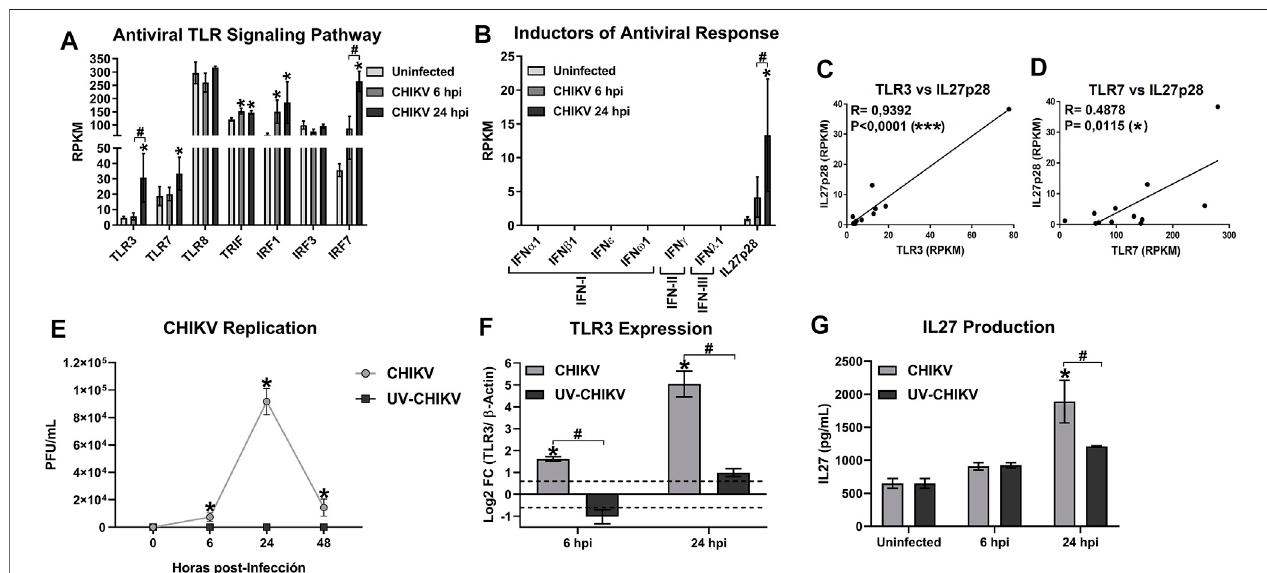
FIGURE 5 | The CHIKV infection of MDMs induces the mRNA expression of TLR3 signaling components, IRF1, and IL27p28. Human MDMs cultures were left uninfectedorinfectedwithCHIKVatMOI5.Celllysateswereobtainedat6and24 hpi,andRNA-seqandRT-qPCRwereperformed.mRNAsabundance(RPKM)ofTLR signaling pathway components and IRFs (A) , IFNs and IL27p28 (B) , in uninfected and CHIKV-infected MDMs. Data are presented as the mean ± SEM. Kruskal – Wallis testwithDunn ’ spost-testwasperformed.Signi fi cantresultsbetweenuninfectedandCHIKV-infectedMDMsarede fi nedas p < 0.05(*), p < 0.01(**)and p < 0.002 (***). Signi fi cant results between treatment-times comparisons are de fi ned as p < 0.05 (#), p < 0.01 (##) and p < 0.002 (###). n = 4. Pearson ’ s correlation between TLR3 (C) or TLR7 (D) , withIL27p28 mRNA abundance (RPKM), inuninfected andCHIKV-infected MDMs. Signi fi cantresultsare de fi ned as p < 0.05 (*), p < 0.01(**) and p < 0.002 (***). Human MDMs cultures were infected at MOI 5 of CHIKV or a non-replicative UV-inactivated CHIKV (UV-CHIKV). CHIKV replication (E) was measure by plaqueassayonverocellsat0,6,24and48 hpi.TLR3mRNAexpression(Log2FC) (F) andIL27cytokineproduction (G) wereevaluatedat0,6and24 hpi,byRT-qPCR and ELISA, respectively. Data are presented as the mean ± SEM. Kruskal – Wallis test with Dunn ’ s post-test was performed. Signi fi cant results between uninfected and CHIKV- or UV-CHIKV-infected MDMs are de fi ned as p < 0.05 (*), p < 0.01 (**) and p < 0.002 (***). Signi fi cant results between CHIKV-infected MDMs and UV-CHIKV- infected MDMs are de fi ned as p < 0.05 (#), p < 0.01 (##) and p < 0.002 (###). n =